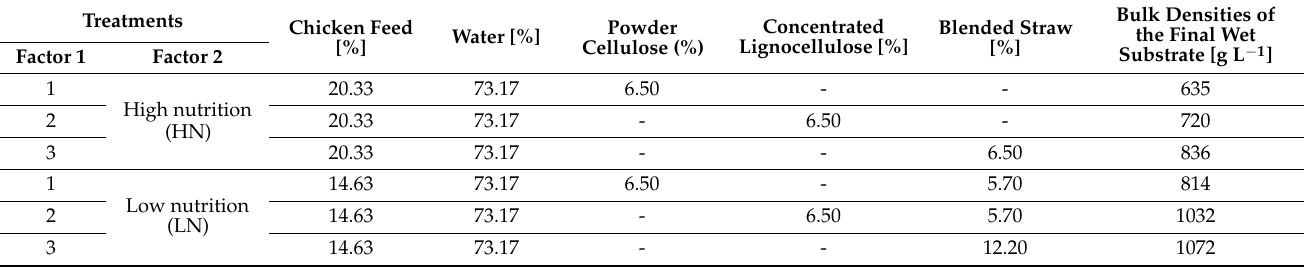
Table 1. Treatments and feed mixtures in the first experiment (wet basis). The characteristics and partial composition of the dry fibre components are provided under the